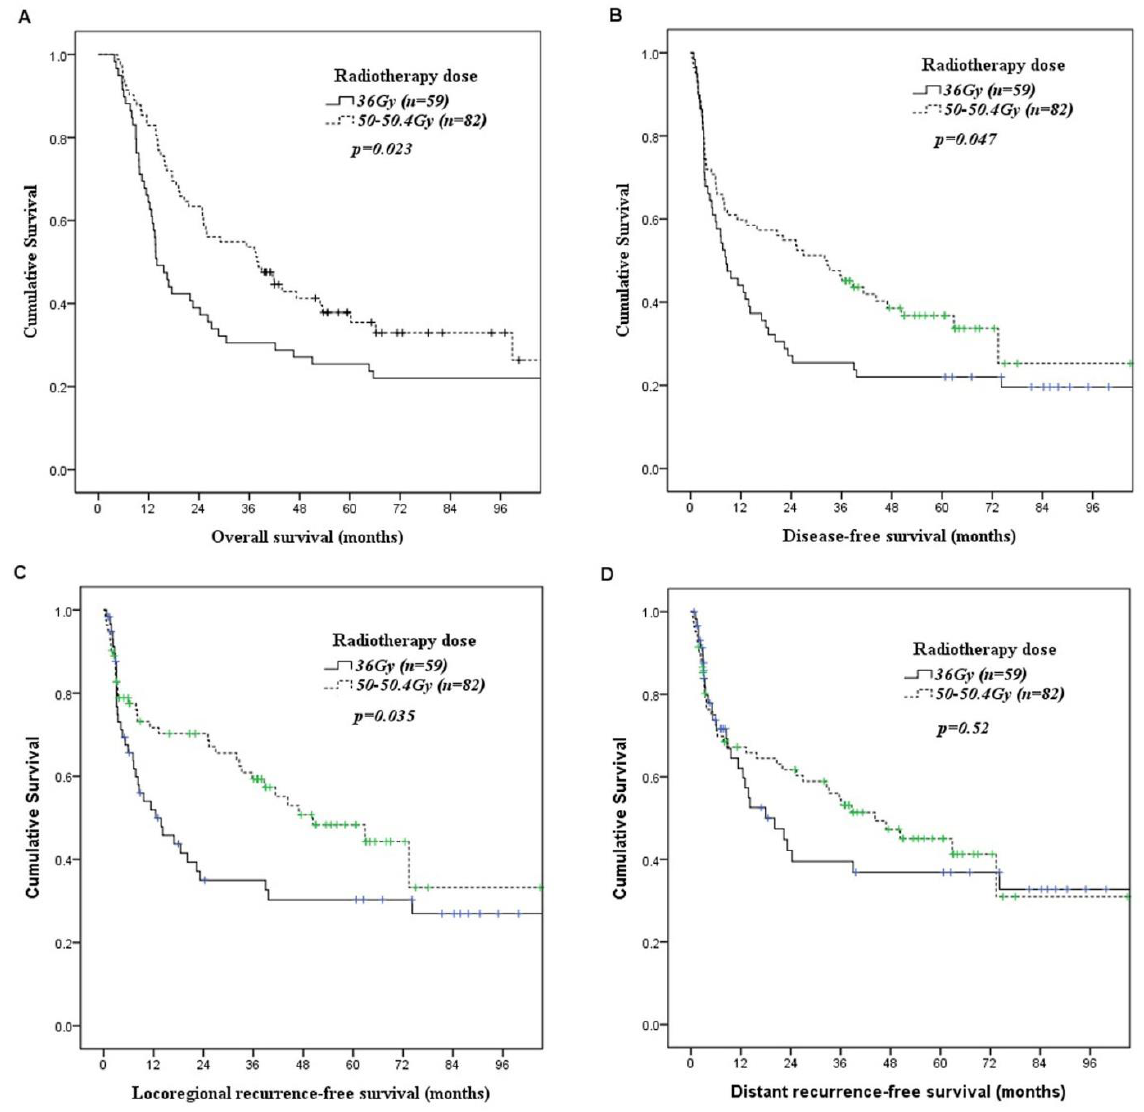
Figure 1. Kaplan–Meier curves according to the radiotherapy dose of preoperative chemoradiotherapy. ( A ) Overall survival. ( B ) Disease-free survival. ( C ) Locoregional recurrence-free survival. ( D ) Distant recurrence-free survival. Table 5. Results of multivariate Cox regression analysis for overall survival and